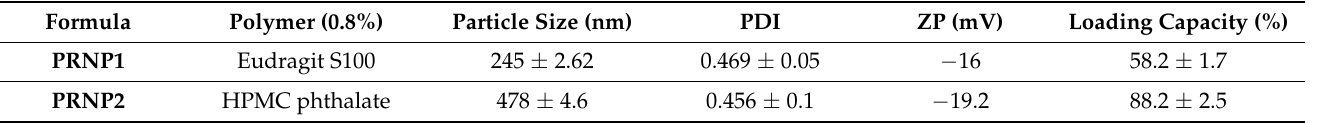
Table 1. Composition of the prepared DOX-PRNPs with full